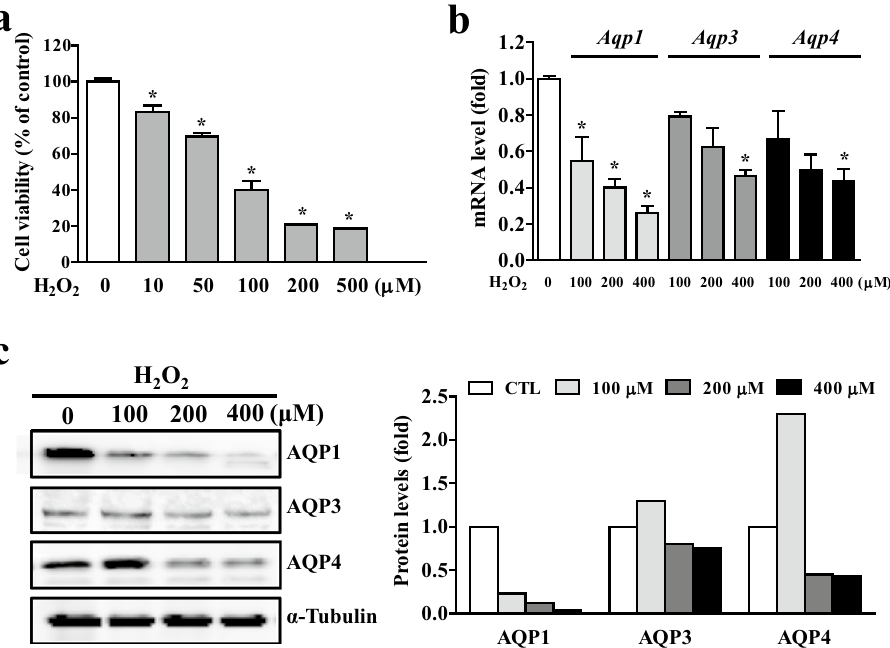
Figure 3. Aquaporin expression levels in chondrocytes by aging-associated factors, ROS. ( a ) Cell viability of chondrogenic C3H10T1/2 cells with a different dose of H 2 O 2 . ( b ) Expressions of AQP1, -3 and -4 mRNA in the presence of H 2 O 2 . ( c ) Western blot analyses for AQP1, -3 and -4 protein expression by a different dose of H 2 O 2 . Densitometric analyses of the western blots are shown on the